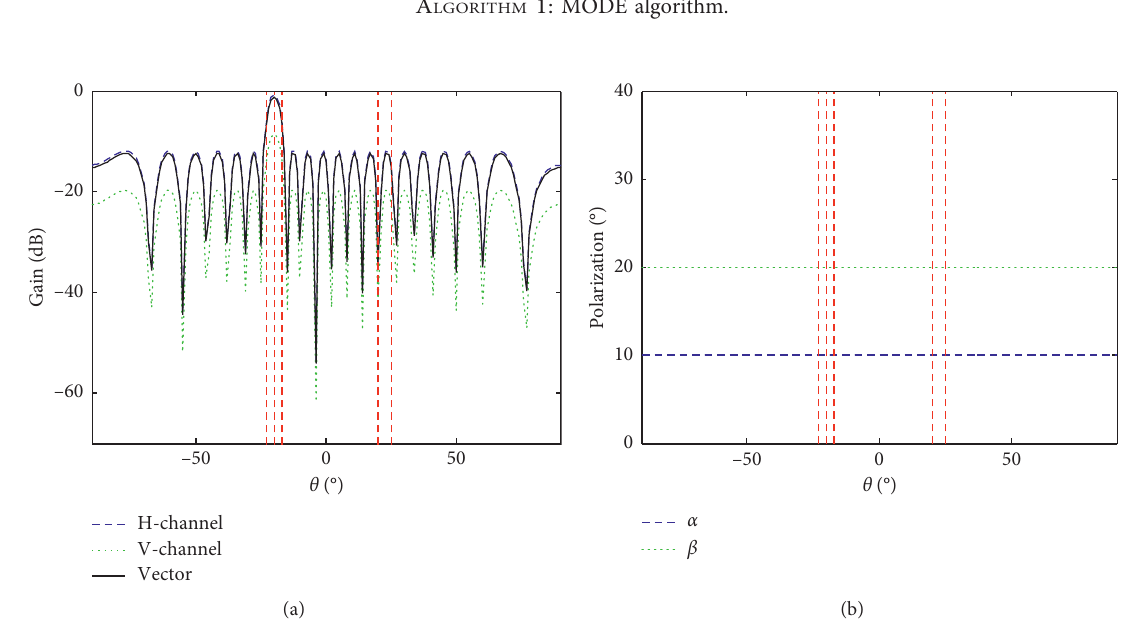
Figure 4: First method of polarized beampattern in [6]. (a) Beampattern. (b)